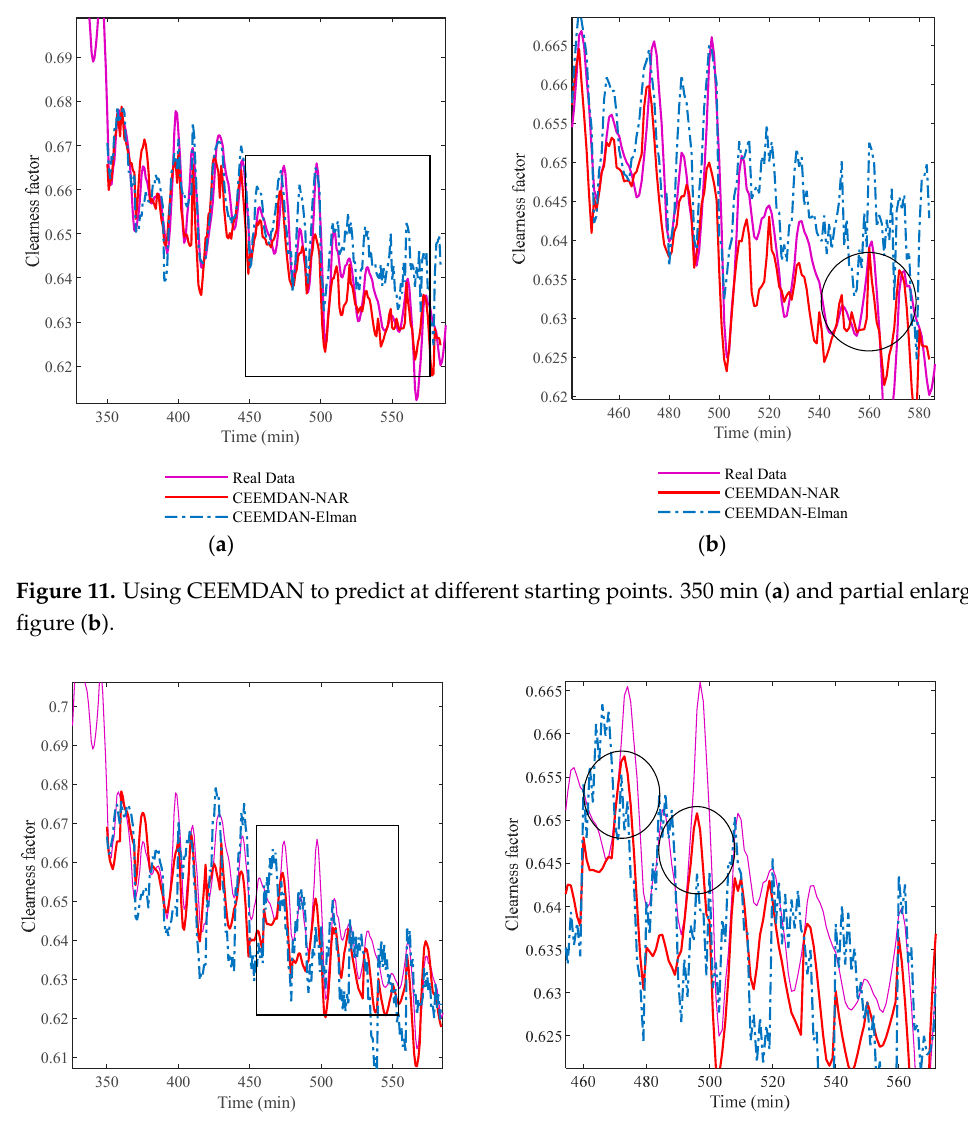
Figure 10. Twenty ‐ step ‐ ahead prediction of M5, M6 without any decomposition algorithm.